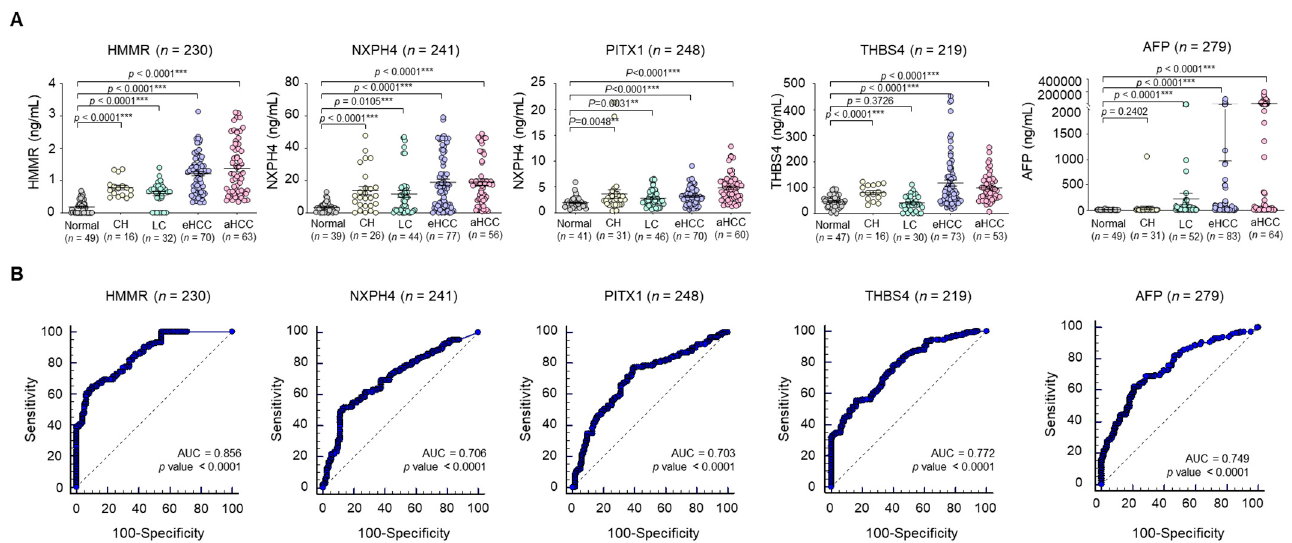
Figure 4. Secretory protein concentration of the four candidate markers in serum in the validation sets. ( A ) Expression of four candidate gene products based on ELISA presented as an aligned dot plot. Black horizontal lines are means, and error bars are SEs. Mann–Whitney U test, p < 0.01 **, p < 0.001 ***. ( B ) The ROC curve analysis of the secretory proteins encoded by the 4 candidate genes in HCC patients versus all control subjects (normal, CH and LC) in the validation cohort. Statistically significant difference of AUC is compared with reference line (AUC = 0.5).